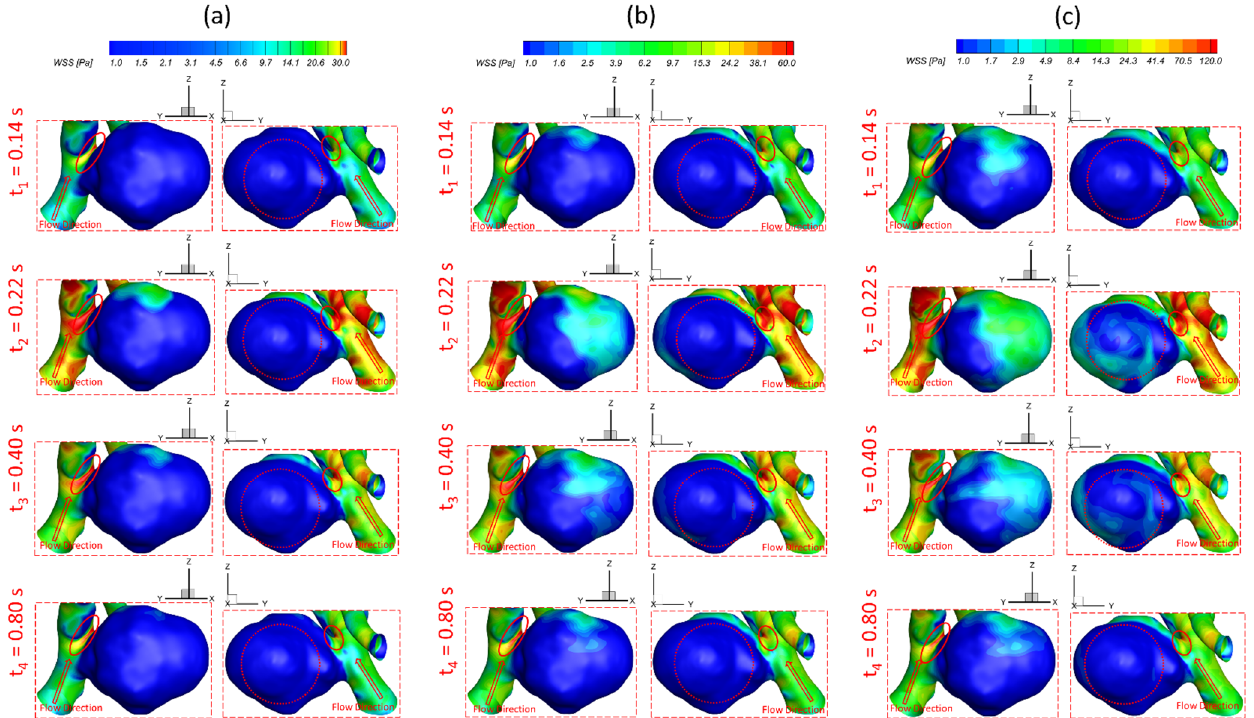
Figure 6. Visualized instantaneous WSS distributions on selected region (R2) of ICASA − 2 model at selected instants and shunt ratio of q A1 :q A2 = 64:36 under corresponded PFRs: ( a ) PFR−I, ( b ) PFR−II, and ( c ) PFR−III.